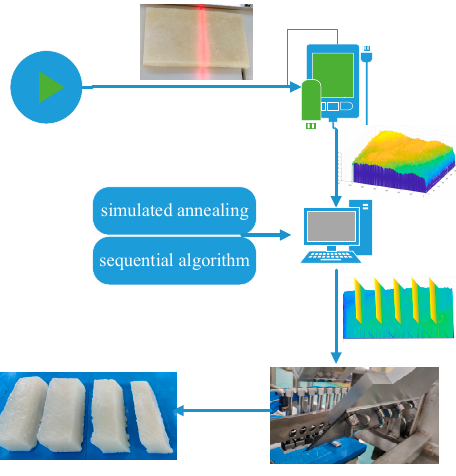
Figure 9. Processing flow chart.